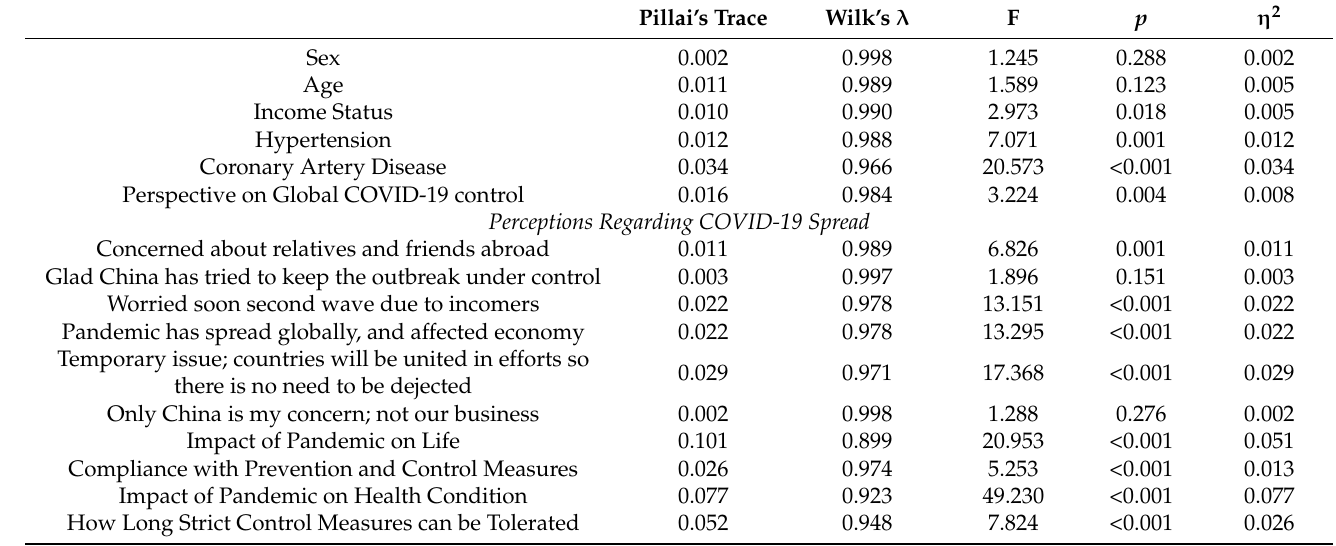
Table 4. Multivariate Analysis of Variance Assessing Correlates of Depressive and Anxious